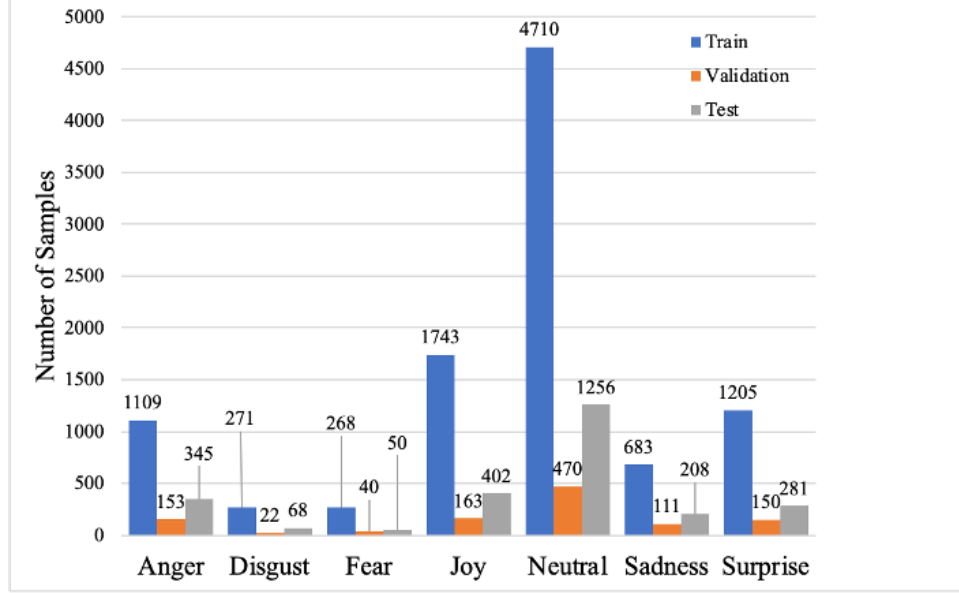
Figure 1. Number of samples per one emotion label for the training, validation, and test